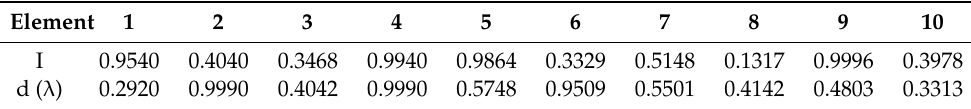
Figure 4. 10 − element CAA. ( a ) Radiation patterns obtained by different algorithms for reducing the PSLL. ( b ) Convergence rates of different algorithms for reducing the PSLL. Table 5. Amplitude (I) and element spacing (d) obtained by using AMPA for 10-element CAA PSLL